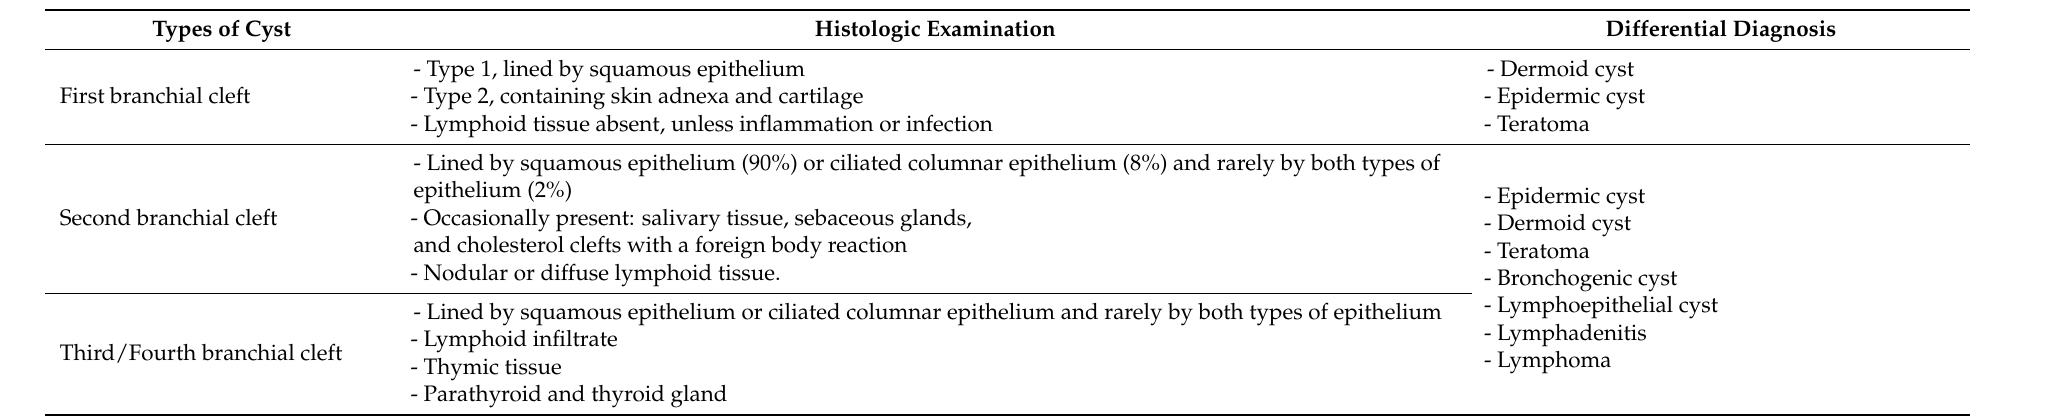
Table 2. Congenital cystic masses of the neck: gross, histologic examination and differential